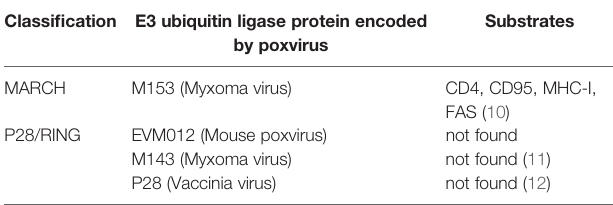
TABLE 1 | Summary of poxvirus E3 ubiquitin ligases.